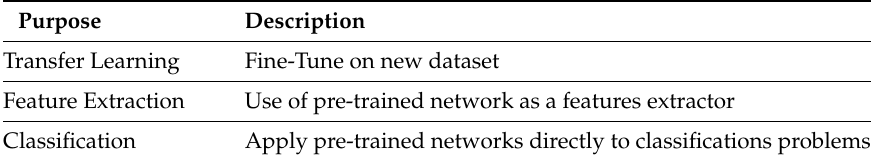
Table 1. Applications of pre-trained CNNs